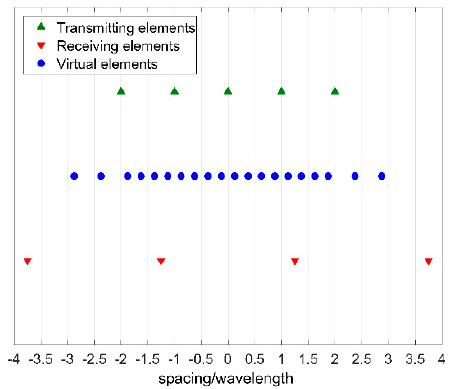
Figure 3. Twenty elements MIMO linear array (in blue) obtained from a five elements transmitting linear array and a four elements receiving linear array.